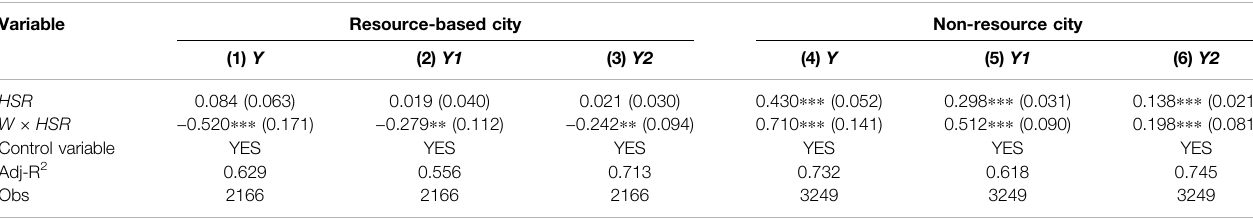
TABLE 2 | Test results of heterogeneity of different resource-based cities.